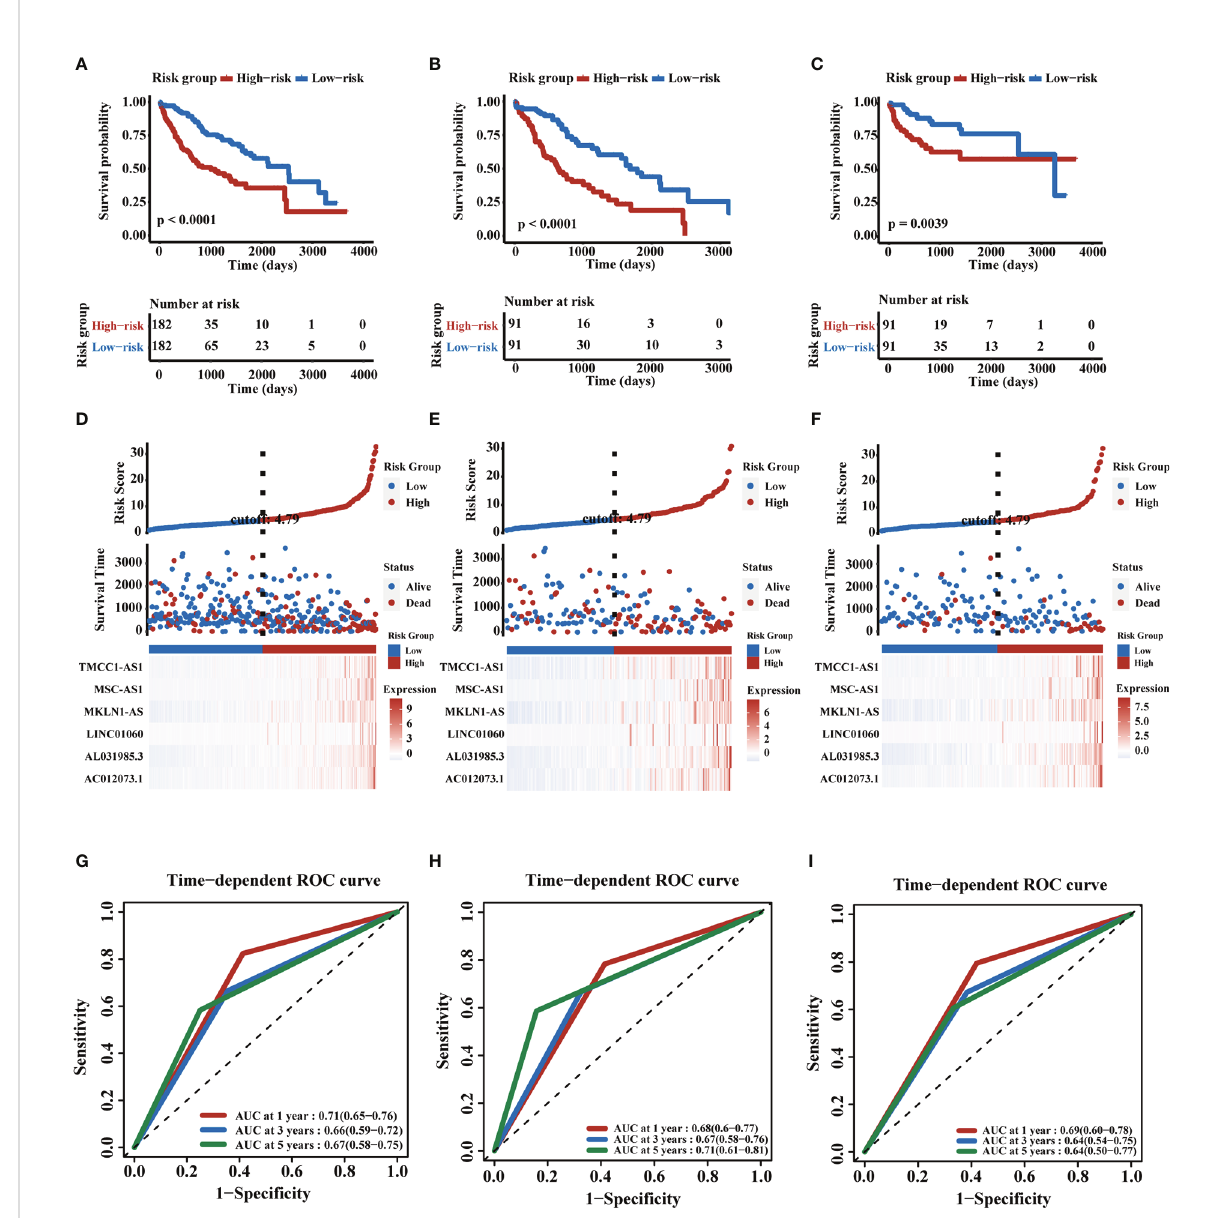
FIGURE 3 Construction and validation of CD4+ Tconv-related lncRNAs prognosis signature. (A – C) K-M plots of training cohort, validation cohort 1, and validation cohort 2. (D – F) RS distribution, survival status, and heatmap of expression of six CD4+ Tconv-related lncRNAs in high-risk and low- risk groups in three cohorts. (G – I) Time-dependent ROC analysis of three